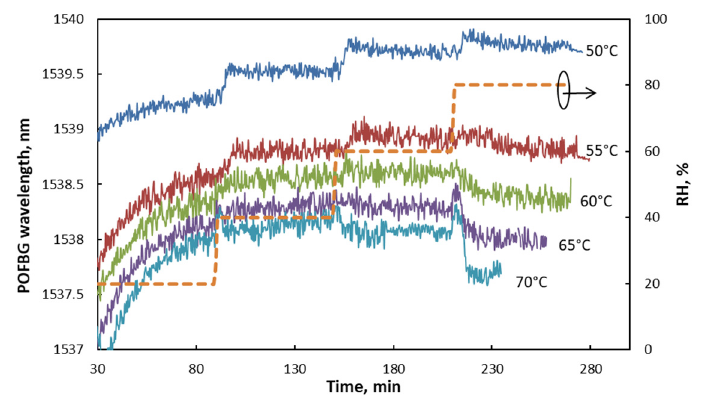
Figure 3. Measured POFBG humidity responses at 50 °C and above.